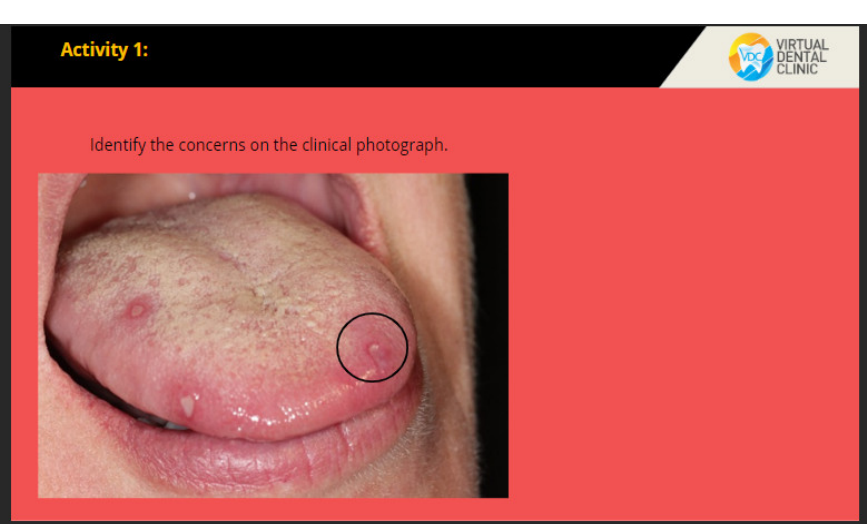
Figure 2. Example of the interactive activity where students can click and identify the areas of concern.